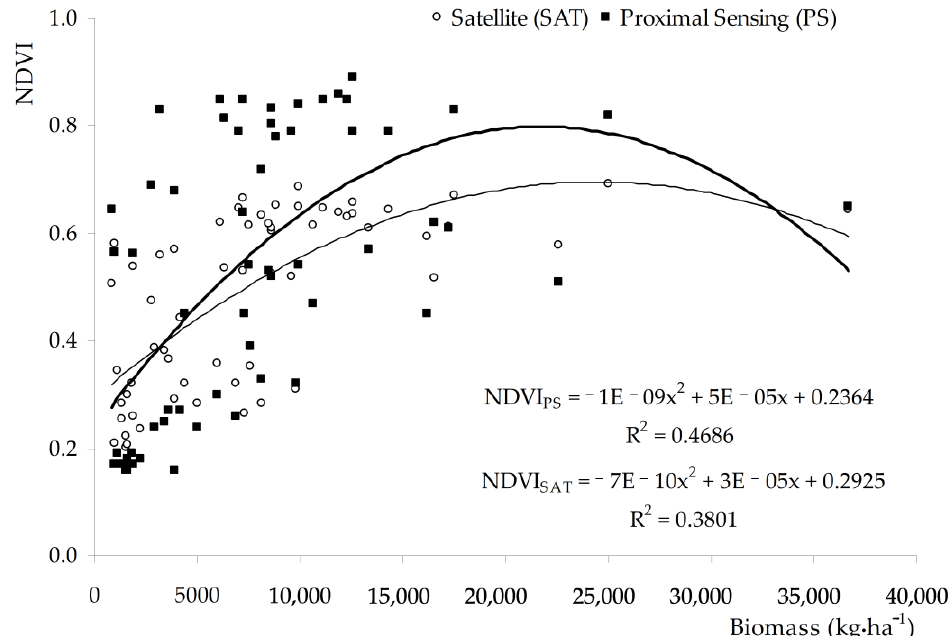
Figure 10. Correlation between vegetation index values (obtained by proximal sensor, NDVI PS ; and by satellite, NDVI SAT ) and pasture biomass, in the set of monthly sampling dates (between February and June 2017).